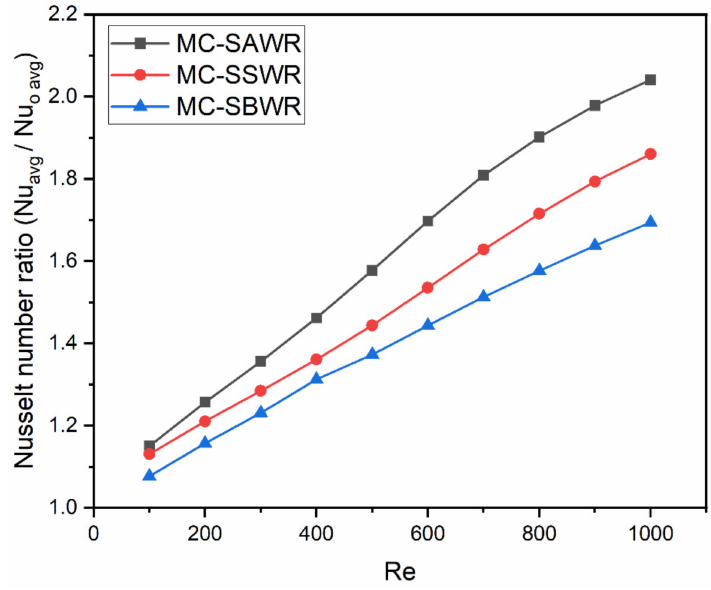
Figure 13. Variation of Nusselt number ratio ( Nu avg / Nu 0 avg ) with Re for different MCHS configurations.